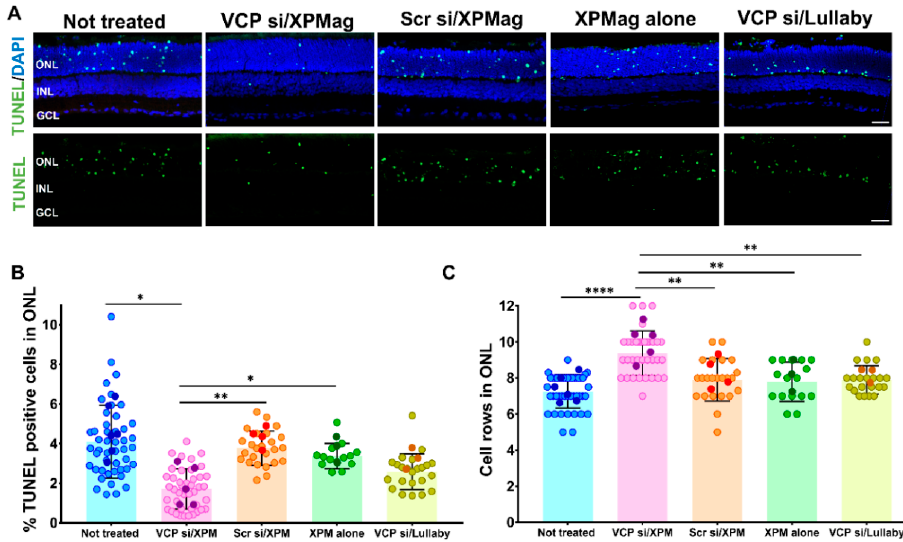
Figure 5. Reverse Magnetofection does not induce cellular toxicity and VCP silencing is neuroprotective in RHO P23H retinal explants. Retinae of RHO P23H transgenic rats were explanted on the postnatal day 12 and cultured in vitro for three days. Retinae were treated with 50 nM VCP si/XPMag, 50 nM Scr si/XPMag, and XPMag alone by Reverse Magnetofection and VCP si/Lullaby by lipofection. ( A ) The explants were stained with the TUNEL assay to differentiate photoreceptors undergoing cell death (green) using nuclei counterstaining with DAPI (blue). ( B ) Bar graph shows the percentage of TUNEL-positive cells in the ONL. After treatment with VCP siRNA/XPMag via Reverse Magnetofection, a significant decrease in the percentage of dying cells was observed compared to the other groups. ( C ) Quantification of the number of photoreceptor cell rows in ONL, calculated by counting DAPI-stained cells in a linear row in three different vertical sections. Retinae treated with VCP siRNA/XPMag via Reverse Magnetofection showed significant preservation of photoreceptor cell rows. Scale bar 50 µ m. The values were quantified by scoring several images (circles) from six retinae ( n = 6) per treatment for not-treated, five retinae ( n = 5) per treatment for VCP si/XPMag, four retinae ( n = 4) per treatment for Scr si/XPMag, and three retinae ( n = 3) per treatment for XPMag alone and VCP si/Lullaby groups. The data are presented as mean ± SD, and one-way ANOVA analysis was performed at * p < 0.05, ** p < 0.01, **** p < 0.0001. The error bars correspond to